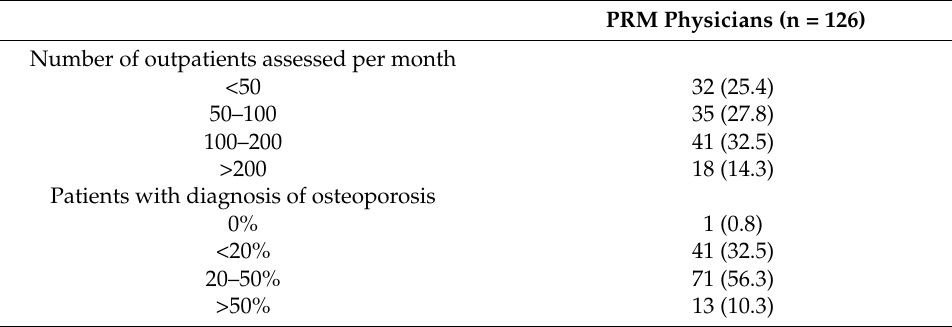
Table 2. Information on outpatients assessed by the physicians in their common clinical practice (questions included in the domain A of the